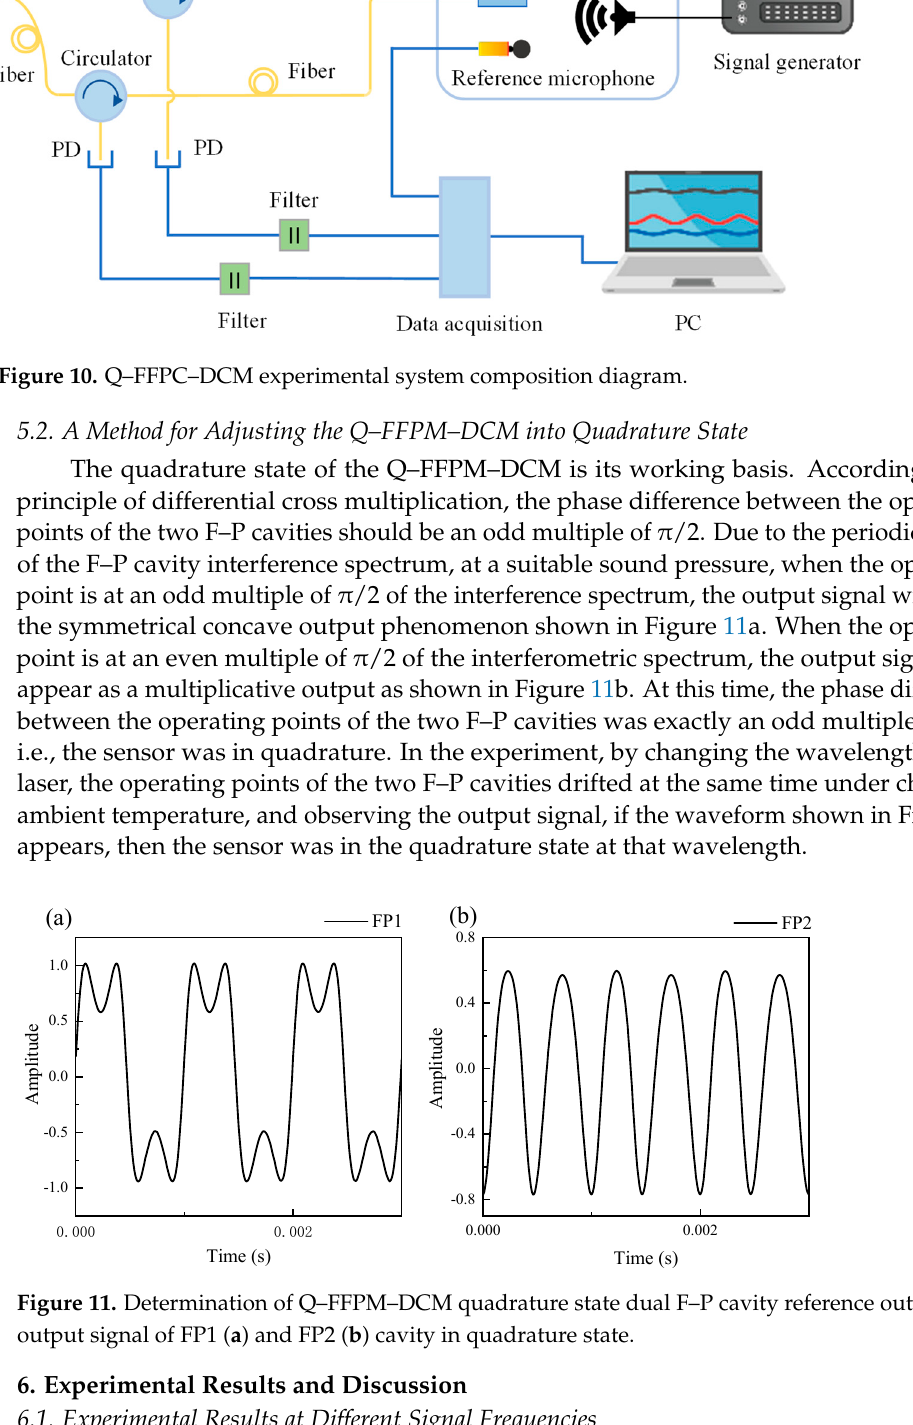
11 of 16 Figure 9. Schematic diagram of Q–FFPM probes ( a ). Microscopic photo of a short step fiber pair ( b ). The diameter of the fiber shown in Figure 9b is 125 μ m. Digital photo of a Q–FFPM probe sample ( c ). The sensor system was built as shown in Figure 10. The monochromatic light from the ZH-550D DFB laser diode (LD) was divided into two beams by the coupler into the quadrature F–P interference cavity, respectively, and the two returned interference sig- nals carrying sound information then passed through the circulator to the photodiode (PD), which converted the light signal into an electrical signal. The two electrical signals